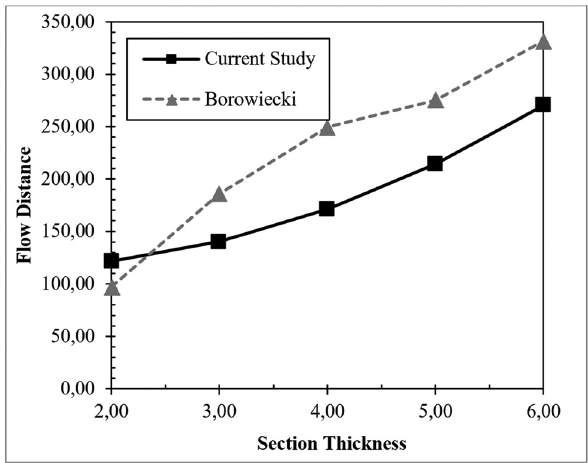
Figure 3: Comparison of the fl ow distance results of the current study with the literature [ 24 ] .